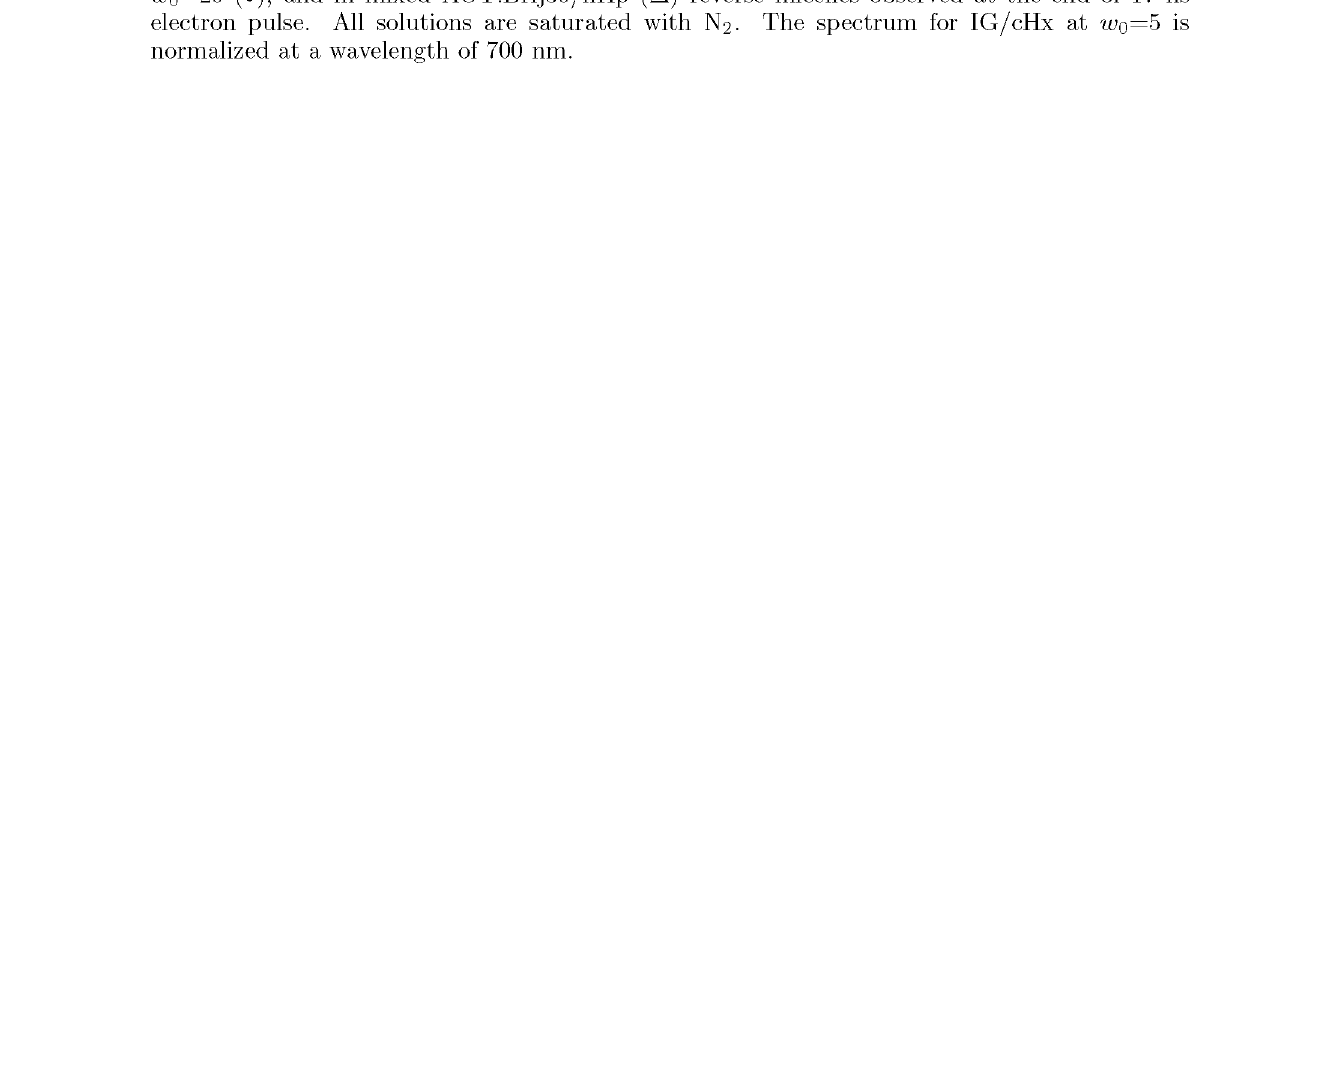
Fig. 1 Absorption spectra of hydrated electrons in IG/cHx reverse micelles at w0 5 (11) and w0 20 (.), and in mixed AOT:Brij30/nHp (A) reverse micelles observed at the end of 17 ns electron pulse. All solutions are saturated with N2. The spectrum for IG/cHx at w0 5 is normalized at a wavelength of 700